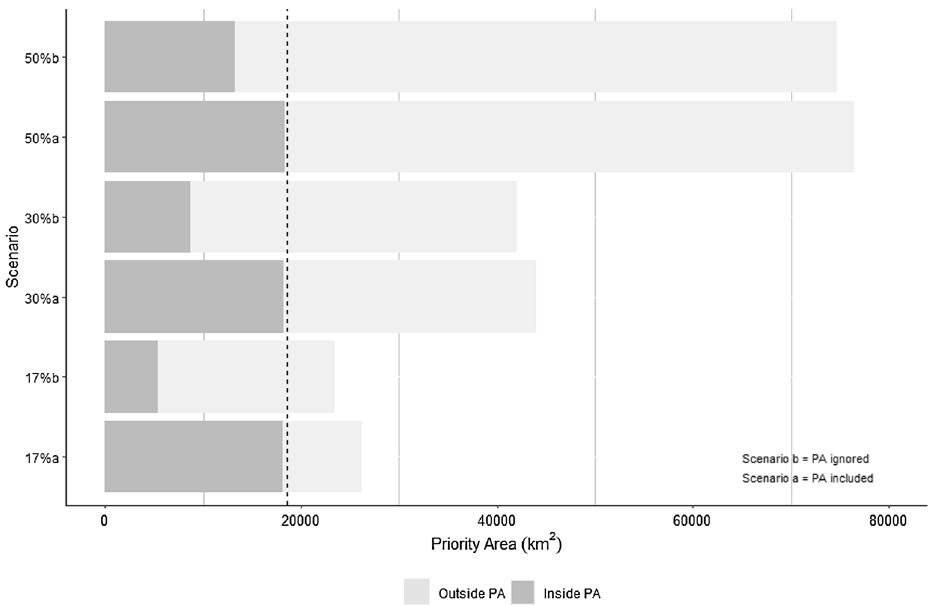
Figure 3. Sulawesi priority area size under six scenarios (two scenarios, ‘a’ and ‘b’, for protected area selection and three protection targets of 17%, 30%, and 50%). The dashed line denotes the total size of Sulawesi’s current protected area